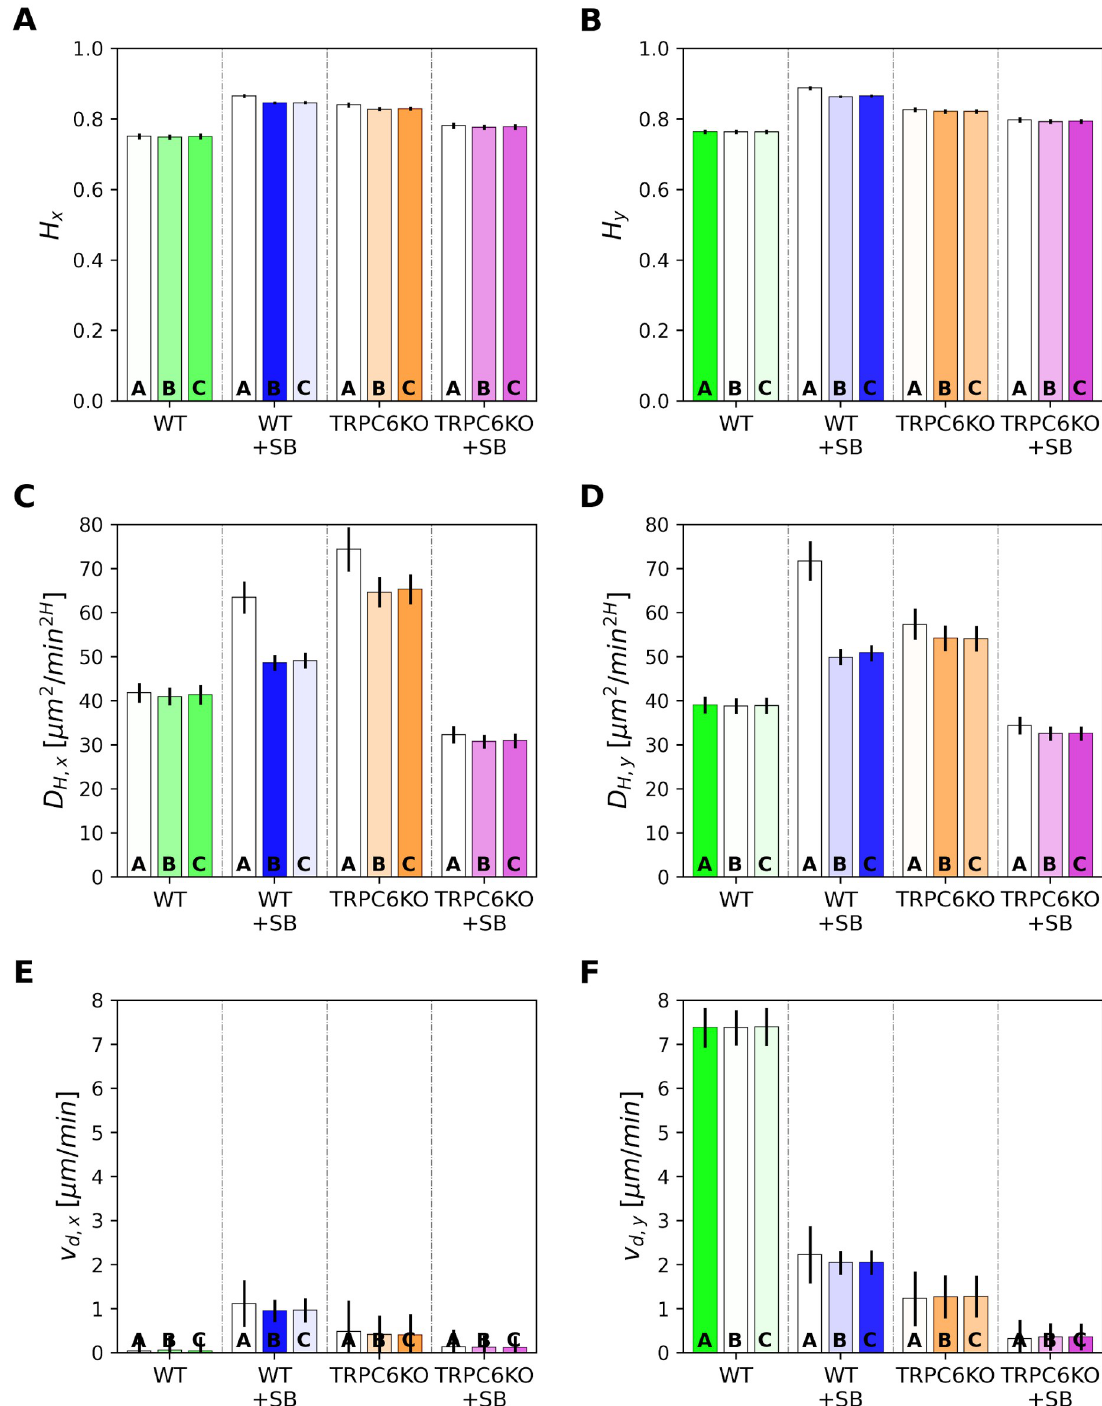
Fig 6. Comparison of model parameters for murine neutrophils. Parameters are plotted in x - and y -direction together with their standard deviation for the three analyzed models: A—fractional Brownian motion (fBm), B—fBm with exponential tempering, and C— fBm with power-law tempering. The color intensities of the parameter bars are proportional to the corresponding model probabilities in Fig 4. (A) and (B) Hurst exponent H , (C) and (D) generalized diffusion coefficient, (E) and (F) absolute value of drift velocity v